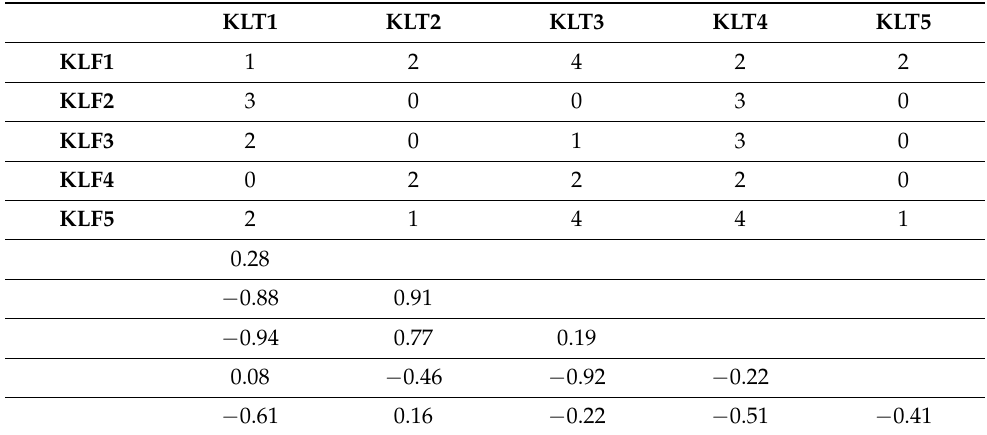
Table 12. Results of the similarity study on a cross-basis of the class set KLF-KLT.